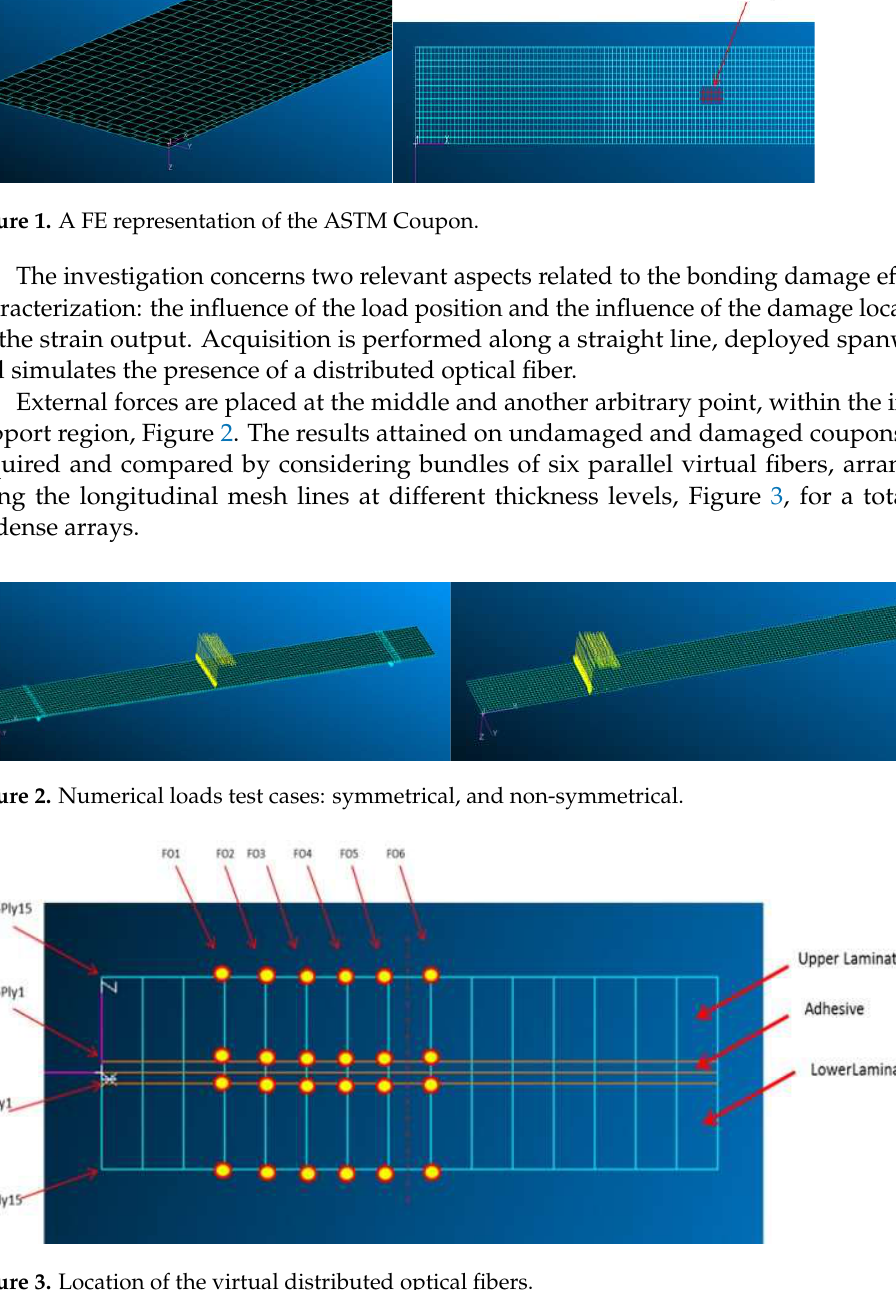
Table 3. Adhesive mechanical properties.